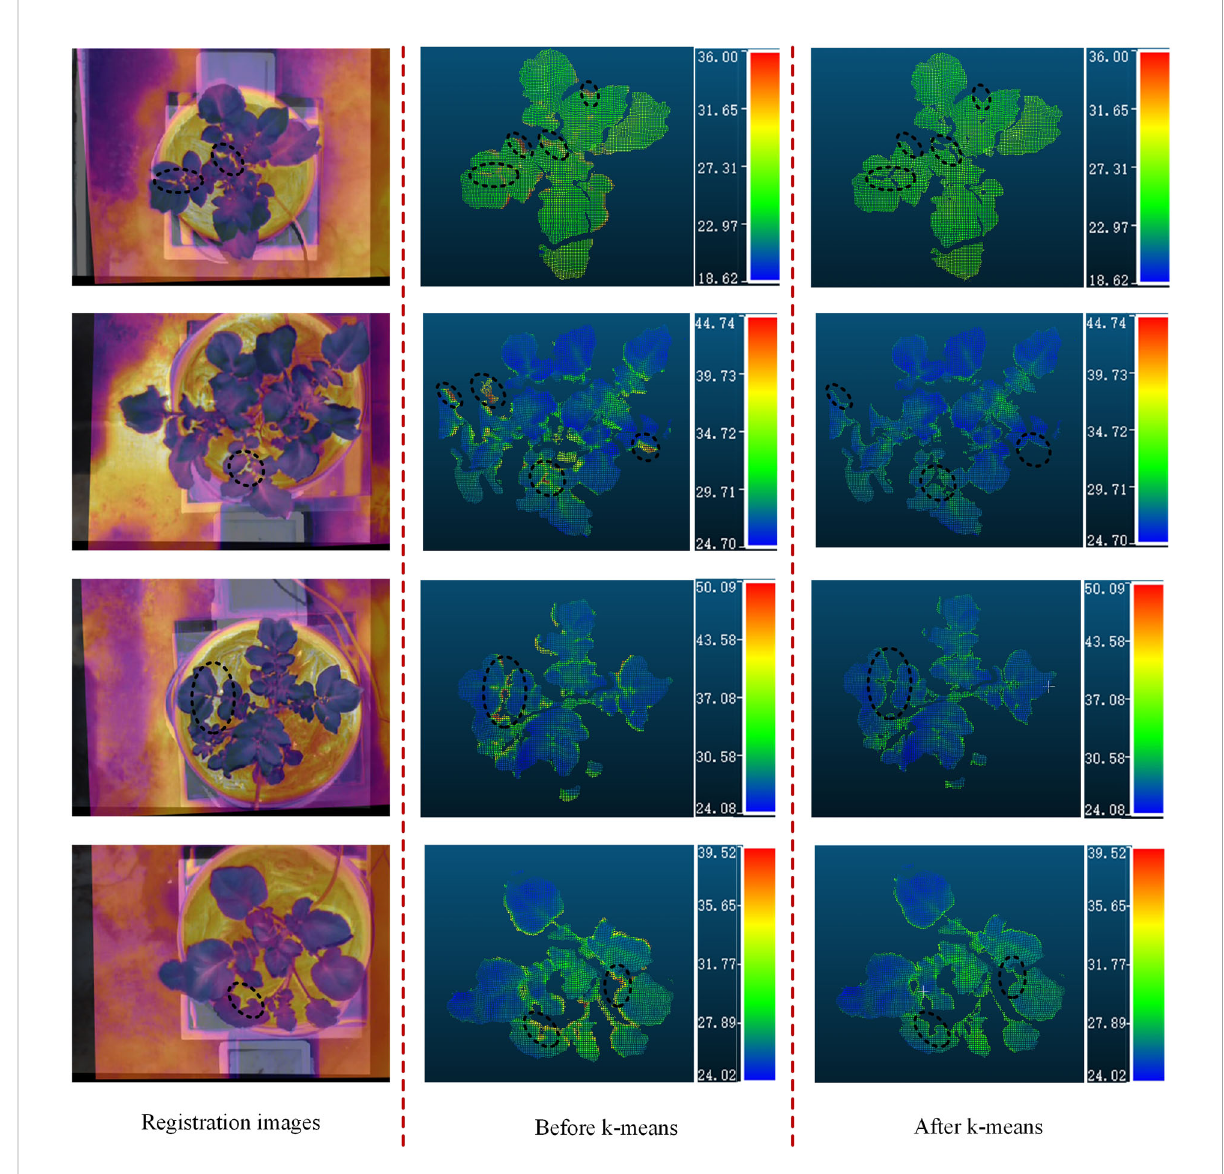
FIGURE 9 Four examples of the processed PCD of potato plant. PCD of potato plant before the k-means and the PCD of potato after the k-means. (unit: